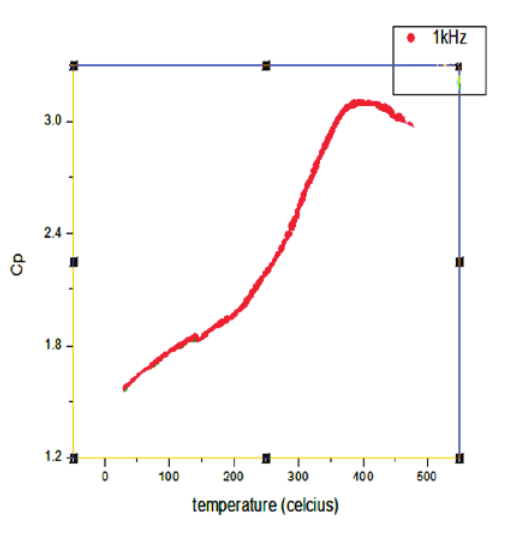
Fig. 4. RPM vs. blade velocity of the CRAV